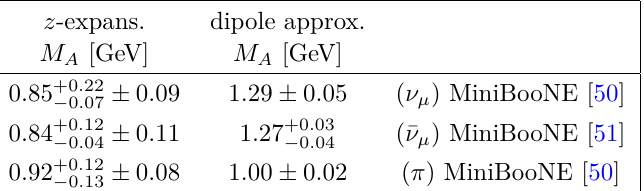
Table 2 . Comparison between z expansion and dipole approximation in MiniBooNE for